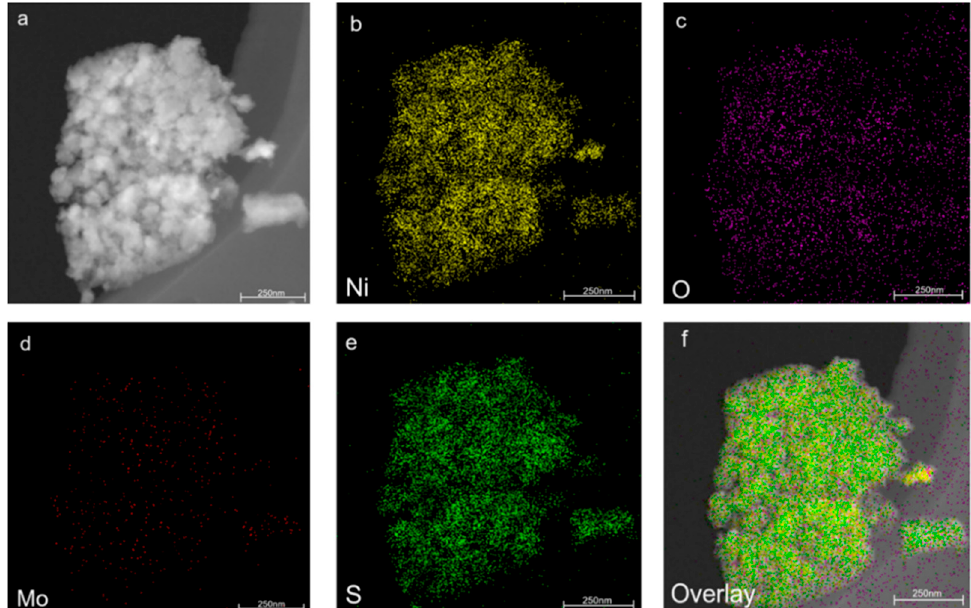
Figure 3. The corresponding element mapping of Ni(OH) 2 /MoS 2 /NF electrocatalysts: ( a ) STEM image; ( b ) Nickel; ( c ) Oxygen; ( d ) Molybdenum; ( e ) sulfur; ( f ) Overlay.